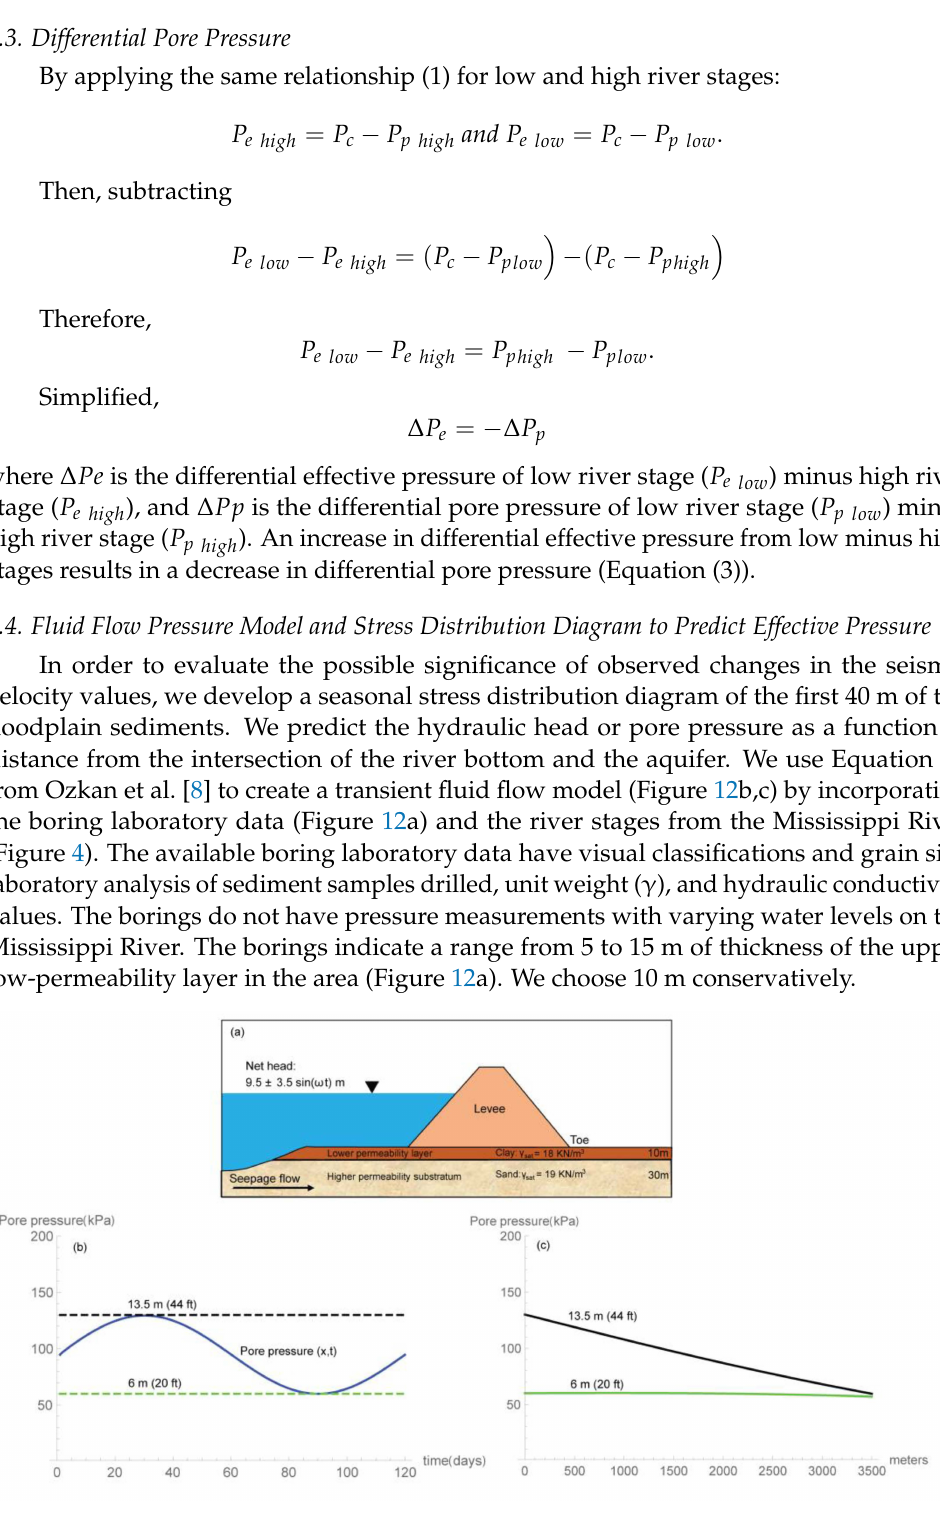
Figure 12. ( a ) Typical levee section with selected parameters from the boring laboratory data to use in the transient fluid flow model created in Wolfram Mathematica. Boring laboratory data include unit weight values ( γ ) and thickness of upper lower permeability clay layer, and higher permeability substratum. Resulting transient fluid flow model with the duration of a flooding event during minimum (6 m) and maximum (13.5 m) river stages in time ( b ) and distance from the levee toe ( c